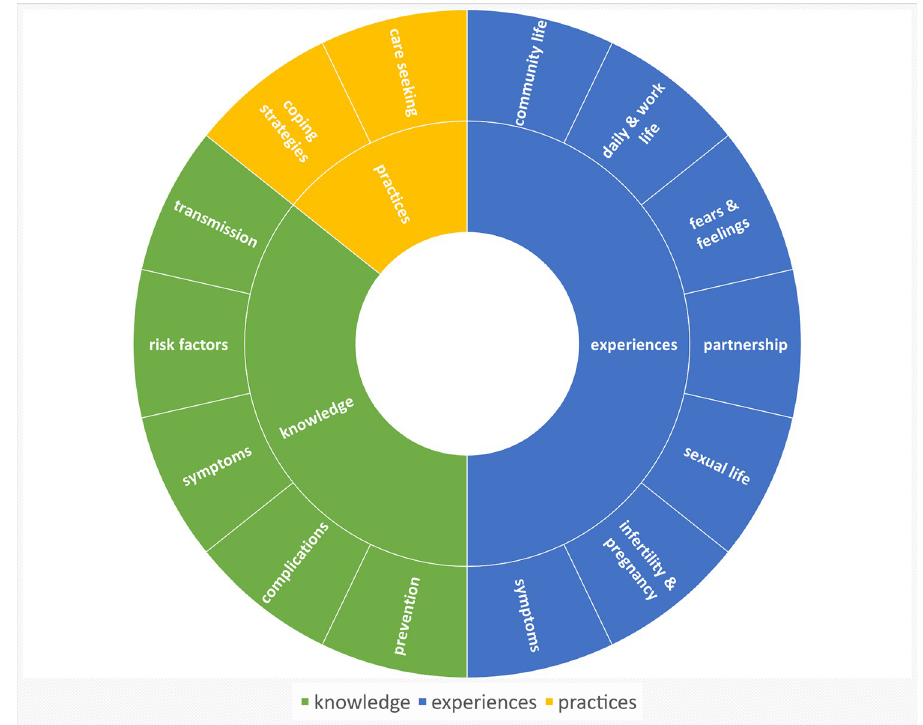
Fig 3. Inductive and deductive main categories and subcategories.